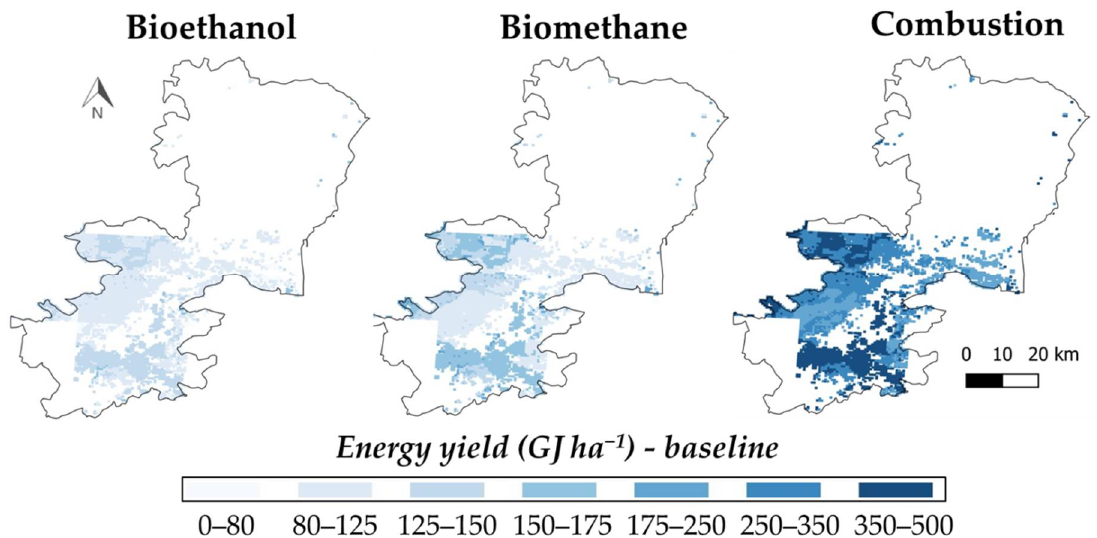
Figure 6. Spatially distributed simulations of energy yield (GJ ha − 1 ) obtainable from different energy sources in the province of Catania under baseline scenario. Results are presented as the average of the values simulated in the whole 30-year period centered on 2000.